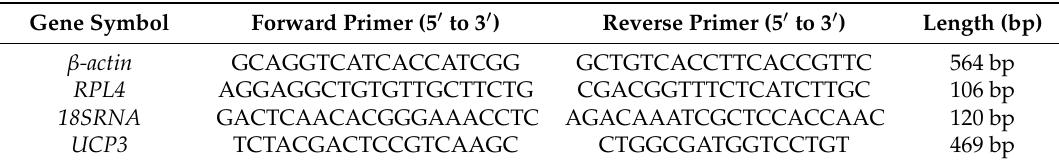
Table 3. Sequences of primers used for real-time